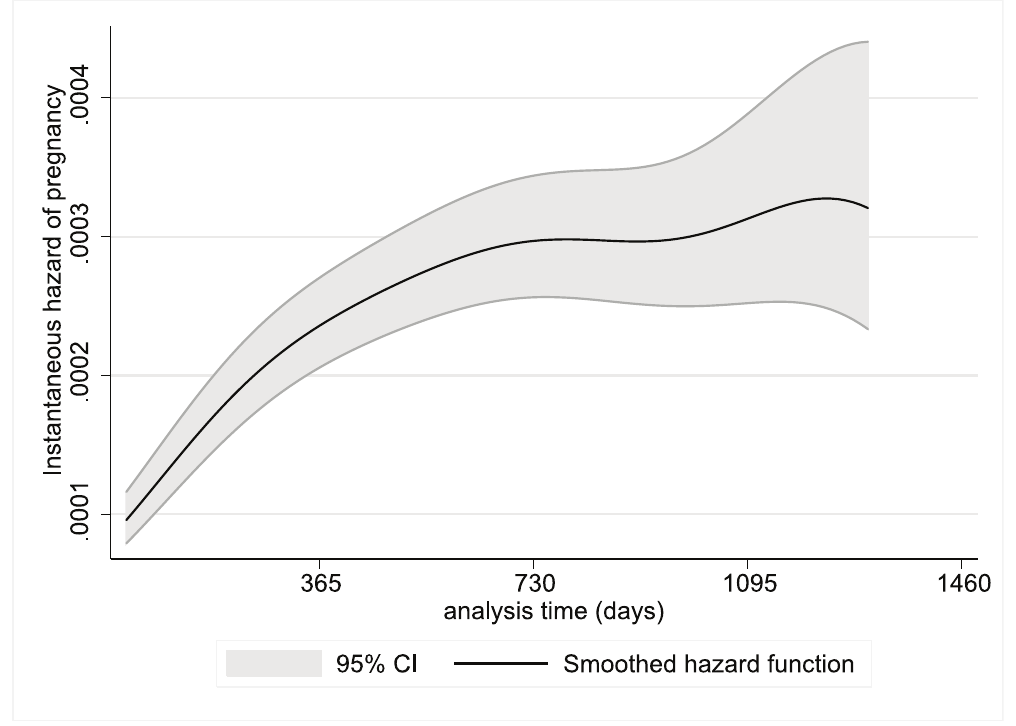
Figure 2. Instantaneous hazard of pregnancy during the on-ART period by duration of follow-up, with 95% CIs.